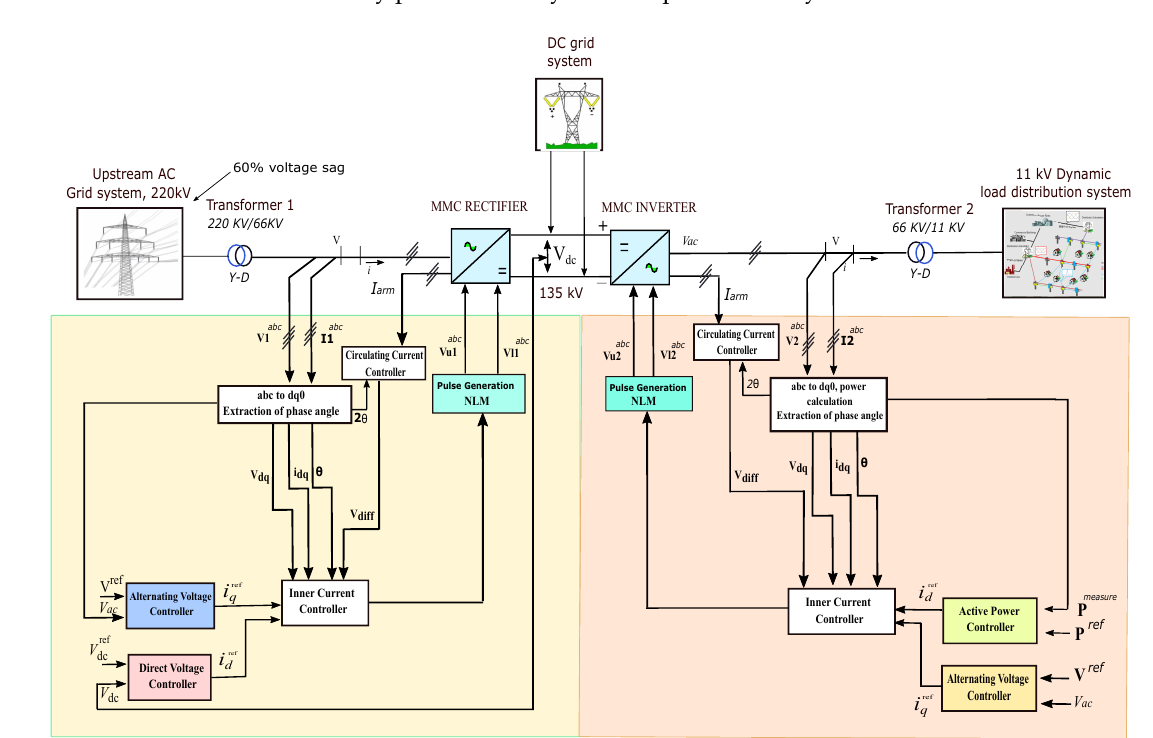
Figure 6. A detailed control system model of the MMC-rectifier and the MMC-inverter. Therefore, to accomplish the principal objective of the proposed scheme, it requires an effective control system for quick response to the system. A dual synchronous reference frame (DSRF)-based current controller is developed for the current control mode of the MMC-rectifier and the MMC-inverter. The outer control loop for the MMC-rectifier consists of AC and DC voltage control, whereas AC voltage and active power control for the MMC- inverter. Circulating current suppression controller is designed to control the differential current in between the phases of modular multilevel converter which distorts the arm currents and increases the peak value of arm current causing system power losses.